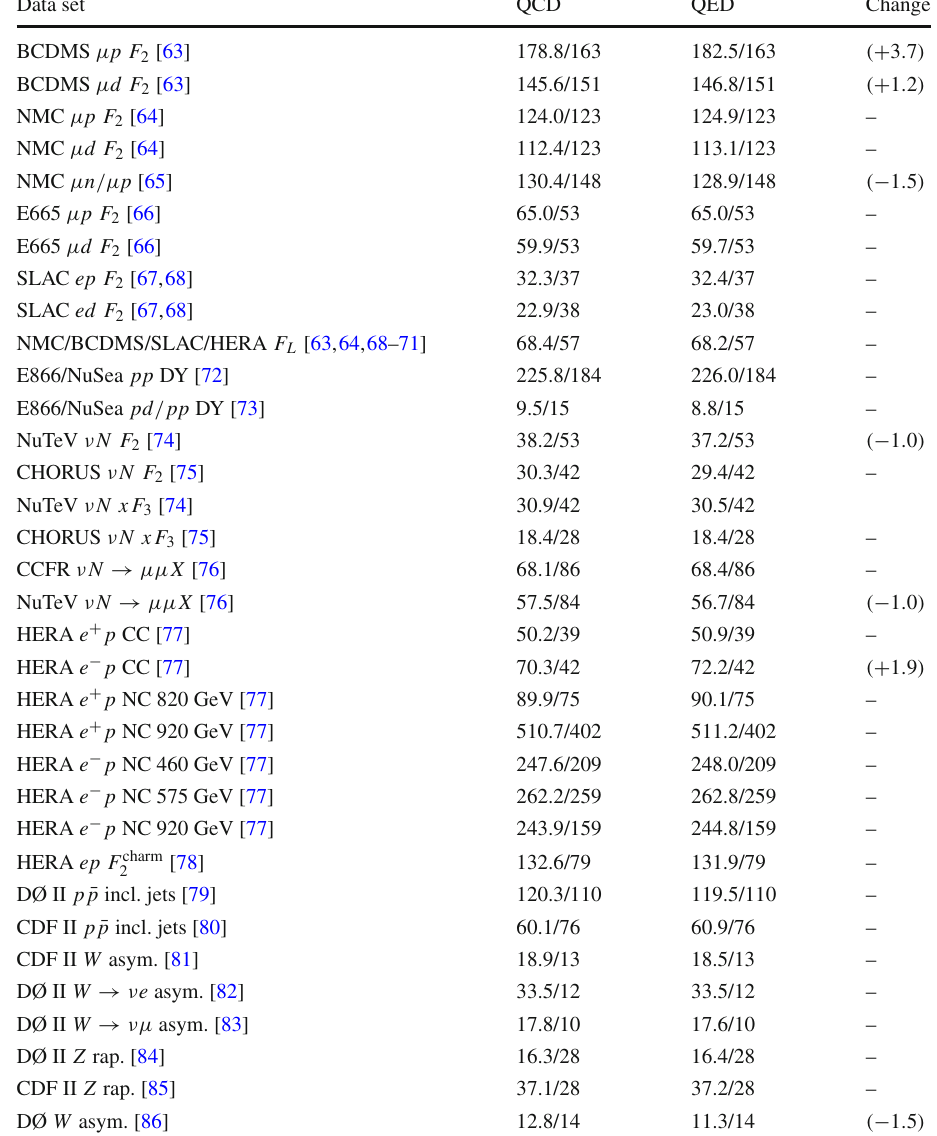
Table 1 The values of χ 2 / N pts for the non-LHC data sets included in a NNLO fit to the MSHT20 dataset, with and without QED corrections. The difference in χ 2 / N pts is also shown explicitly, for the cases that the magnitude is larger than 1 point; negative values indicate a better fit quality in the